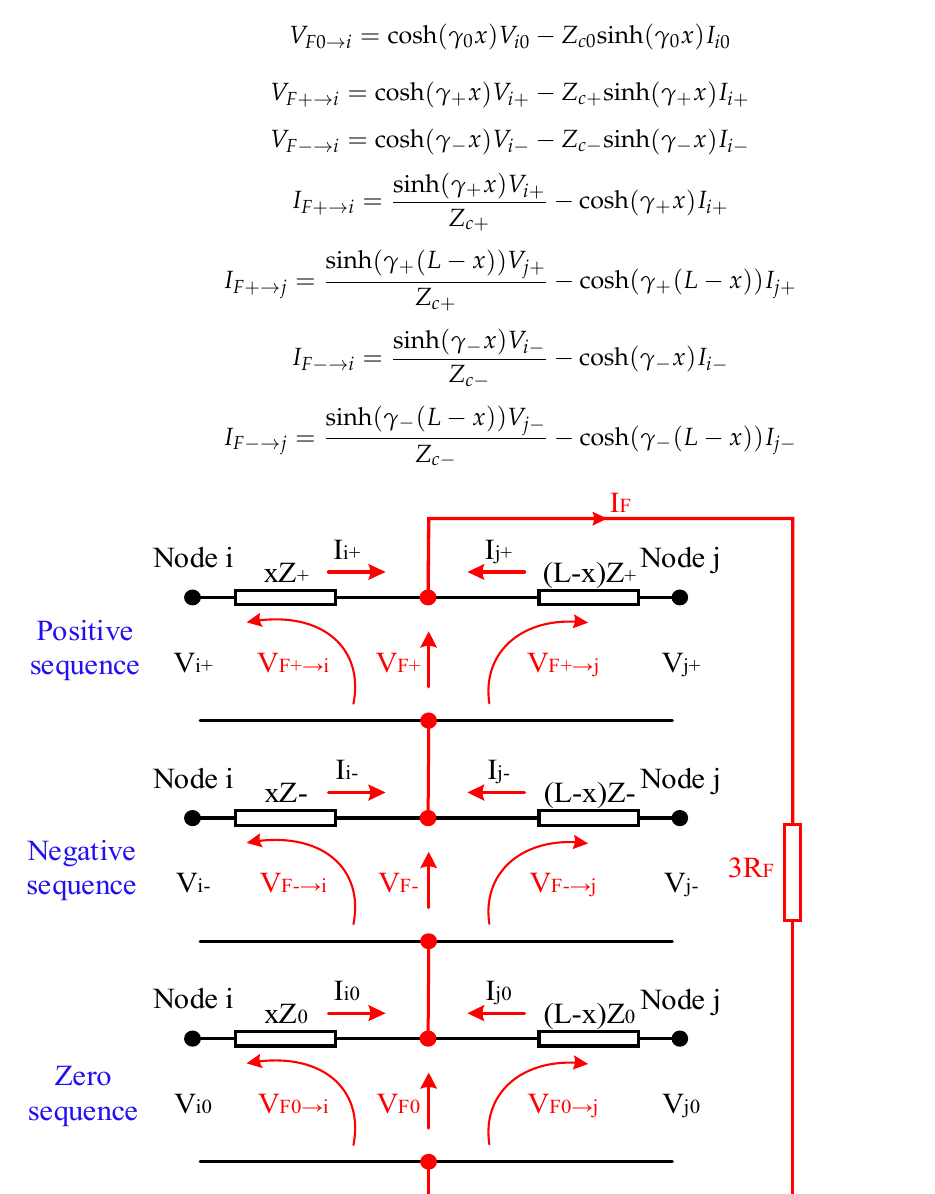
Figure 12. Equivalent circuit of positive, negative, and zero sequences of single-phase fault to ground.